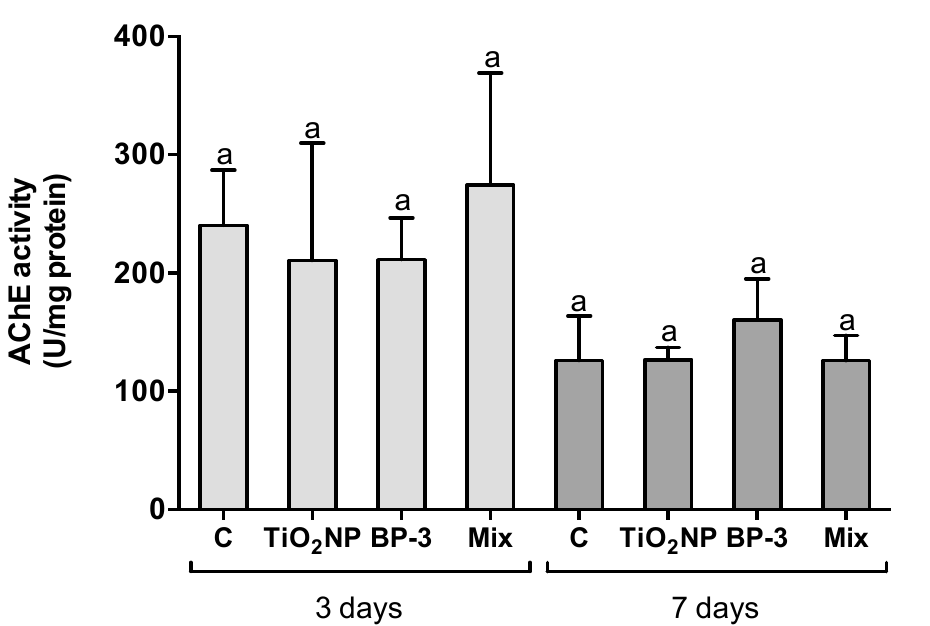
Figure 6. Neurotoxic profile depicted in the brain acetylcholinesterase (AChE) activity of S. maximus , 3 and 7 days after intraperitoneal injection of titanium dioxide nanoparticles (TiO 2 NPs; 3.0 μ g TiO 2 NP per g fish weight), oxybenzone (BP-3; 3.0 μ g BP-3 per g fish weight) or their mixture (Mix), as well as the respective control group (C). Different lower-case letters denote significant differences ( p < 0.05). Columns correspond to mean and error bars represent the standard deviation.